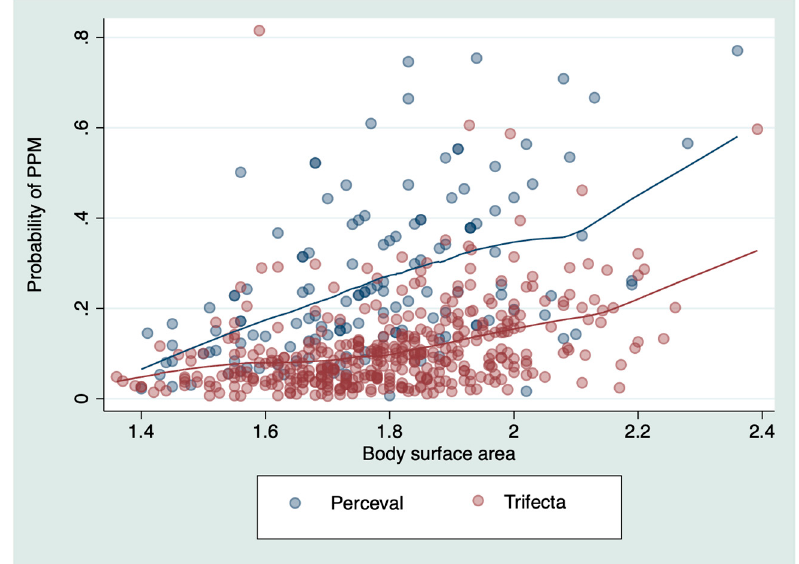
Figure 4. Predicted probability of PPM according to different body surface area in our sample. Lines are formed by a lowess function. PPM: patient – prosthesis mismatch.